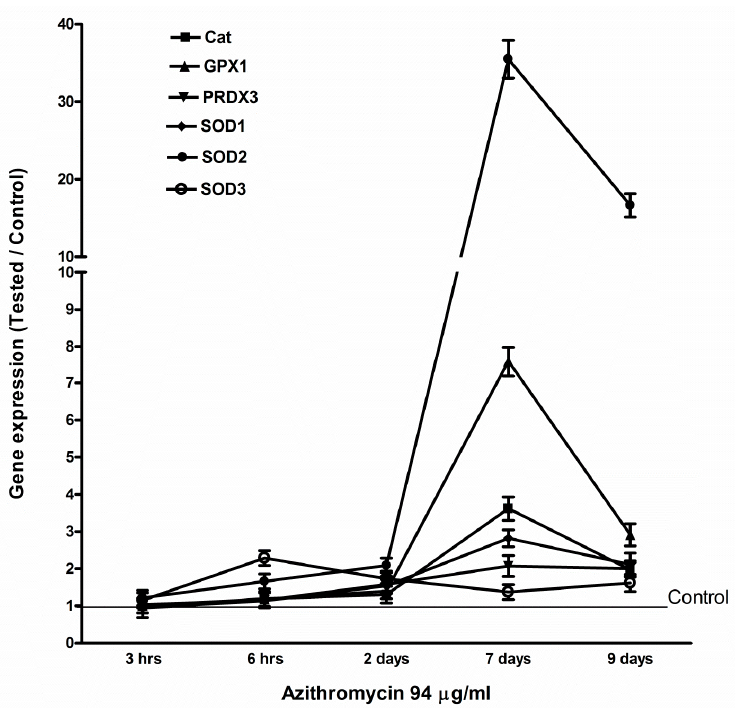
Figure 6. Azithromycin upregulated the expression of antioxidant genes in MCF-12A cells. Cat : catalase; GPX1 : glutathione peroxidase 1; PRDX3 : peroxiredoxin 3; SOD1 , - 2 , - 3 : superoxide dismutase 1, 2, 3. Antibiotics 2019 , 8 , x FOR PEER REVIEW